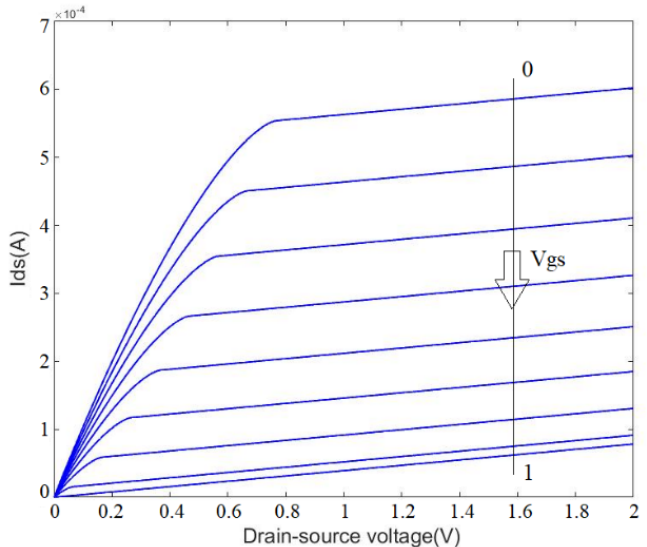
Figure 13. Mathematical results of the Ids–Vds curves for different Vgs values from 0 to 1 with 0.1 steps. The model can predict the sensors response in low values of drain–source voltages before saturation. The back ‐ gate voltage is also limited to the Vpo for good accuracy.